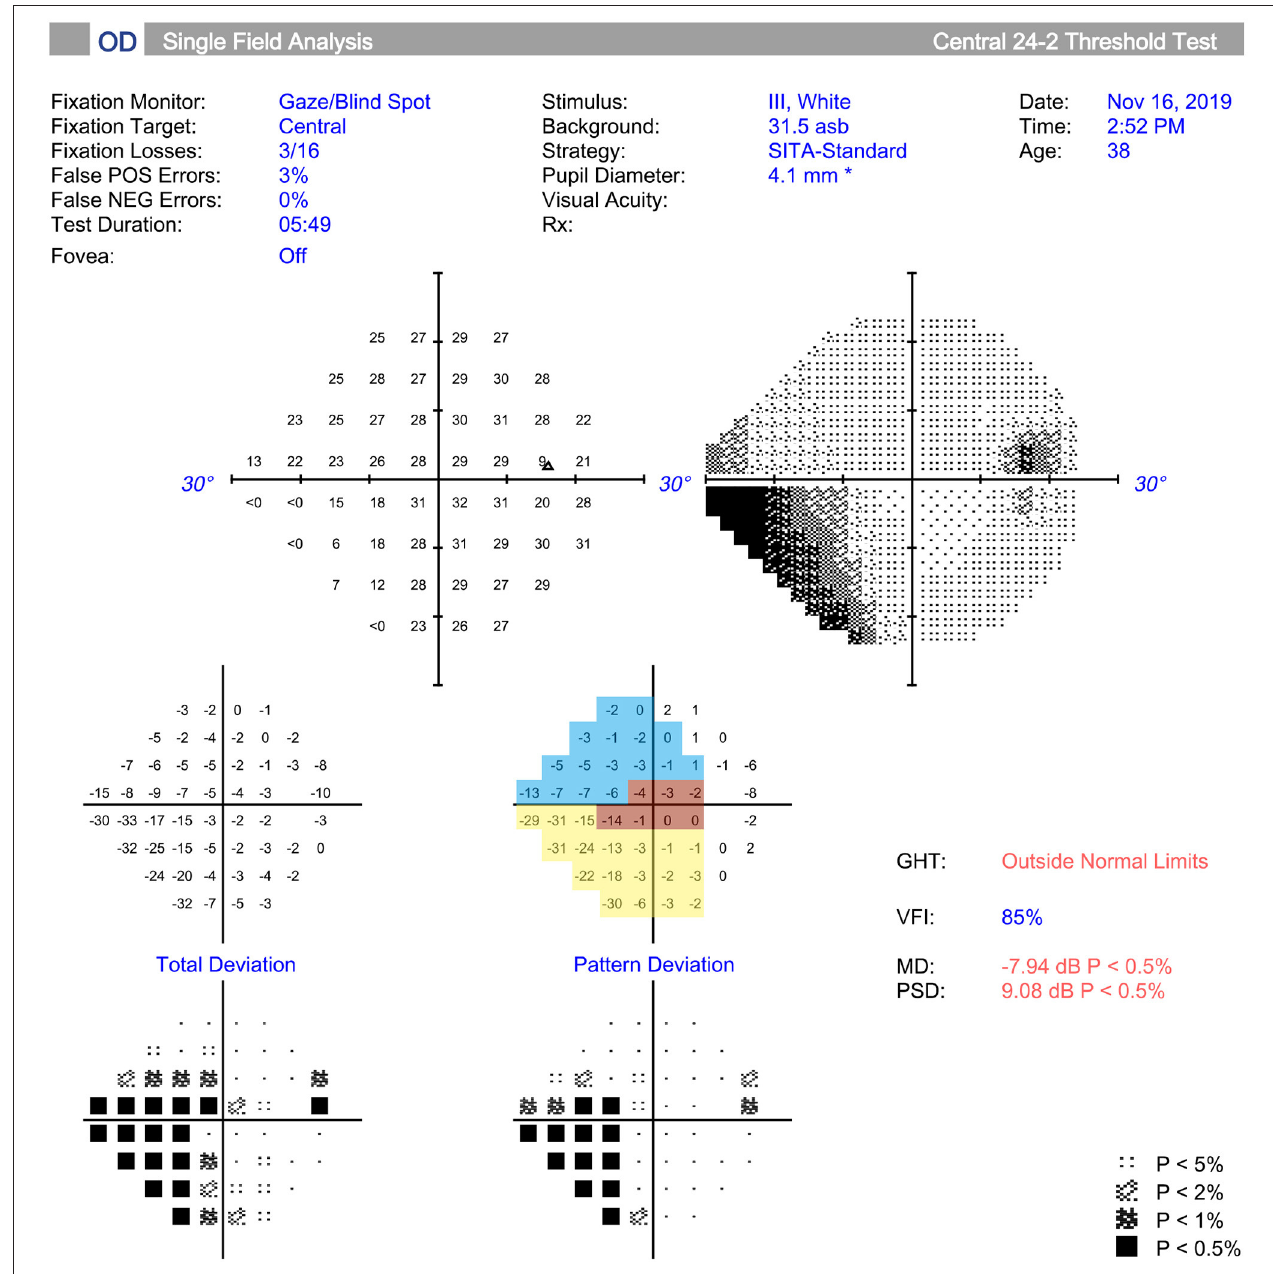
FIGURE 1 | Measurement and regionalized of the visual field (VF) were demonstrated. The VF was tested (Humphrey automated perimetry SITA 24-2), and regionalized into the temporal (T) (315 ◦ -45 ◦ , red area), temporal superior (TS) (45 ◦ -90 ◦ , yellow area), and temporal inferior (TI) (270 ◦ -315 ◦ , blue area) sectors according to previous study. Regional visual field sensitivity (VFS) was calculated as the sum of the pattern deviations in a specific sector.